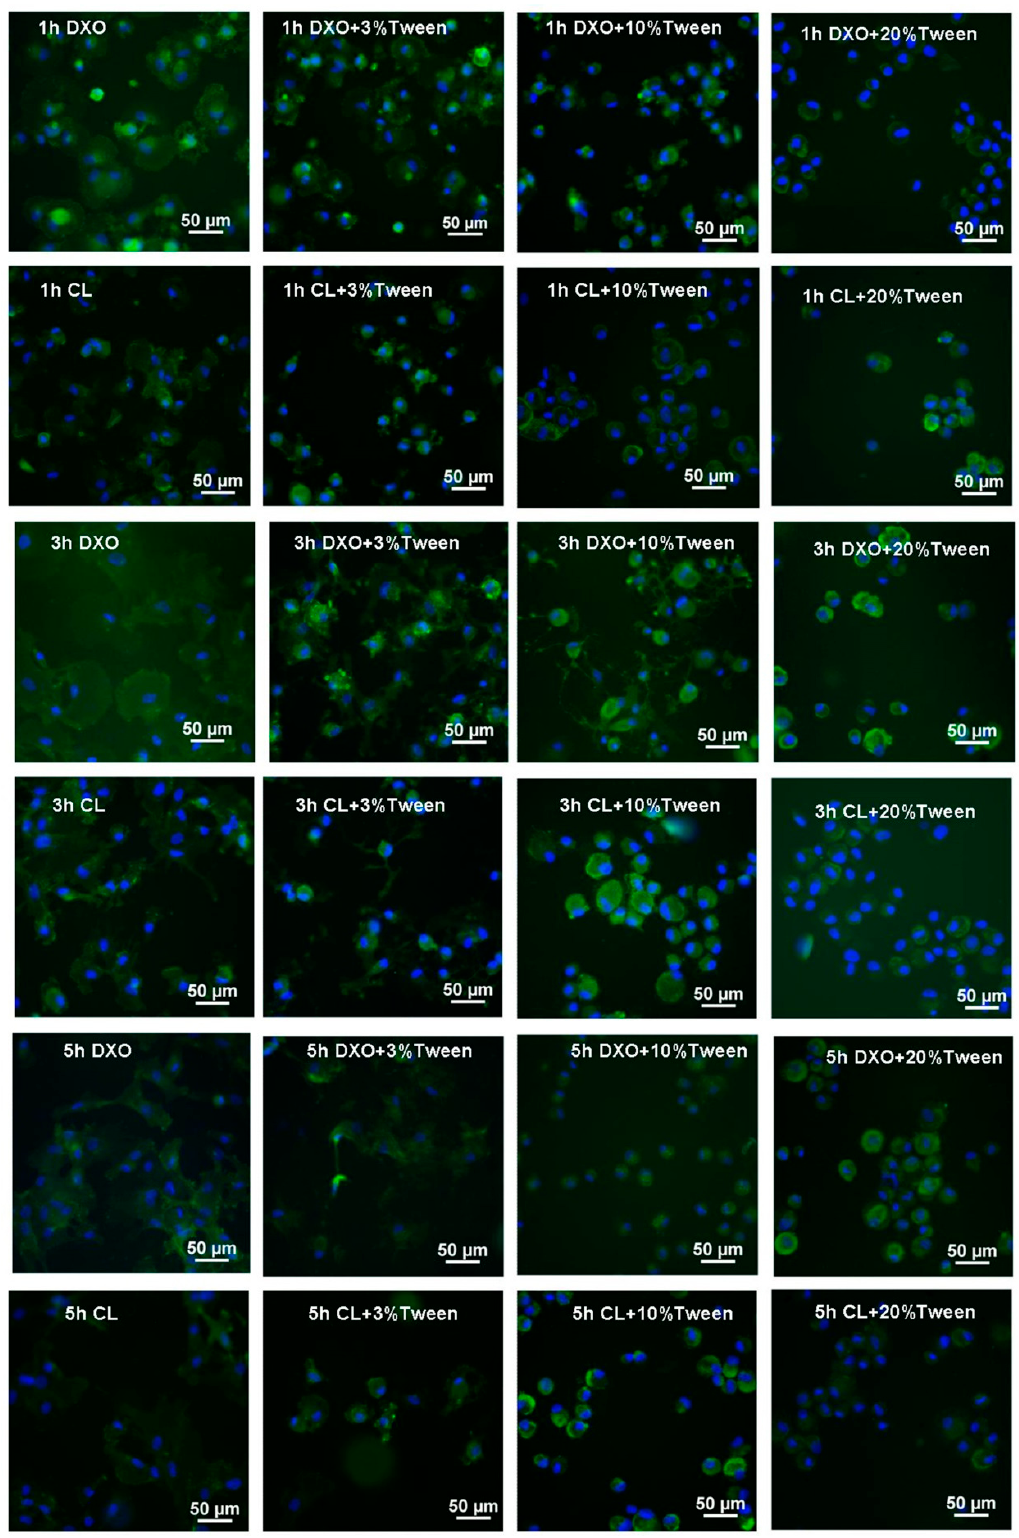
Figure 4. Spreading of human bone marrow mesenchymal stem cells (hMSCs) on membranes of different groups from 1 to 5 h. hMSCs were stained with fluorescein isothiocyanate conjugated cluster of differentiation 90 (FITC-CD90) (green) and all nucleus with 4 ′ ,6-diamidino-2-phenylindole (DAPI) (blue)